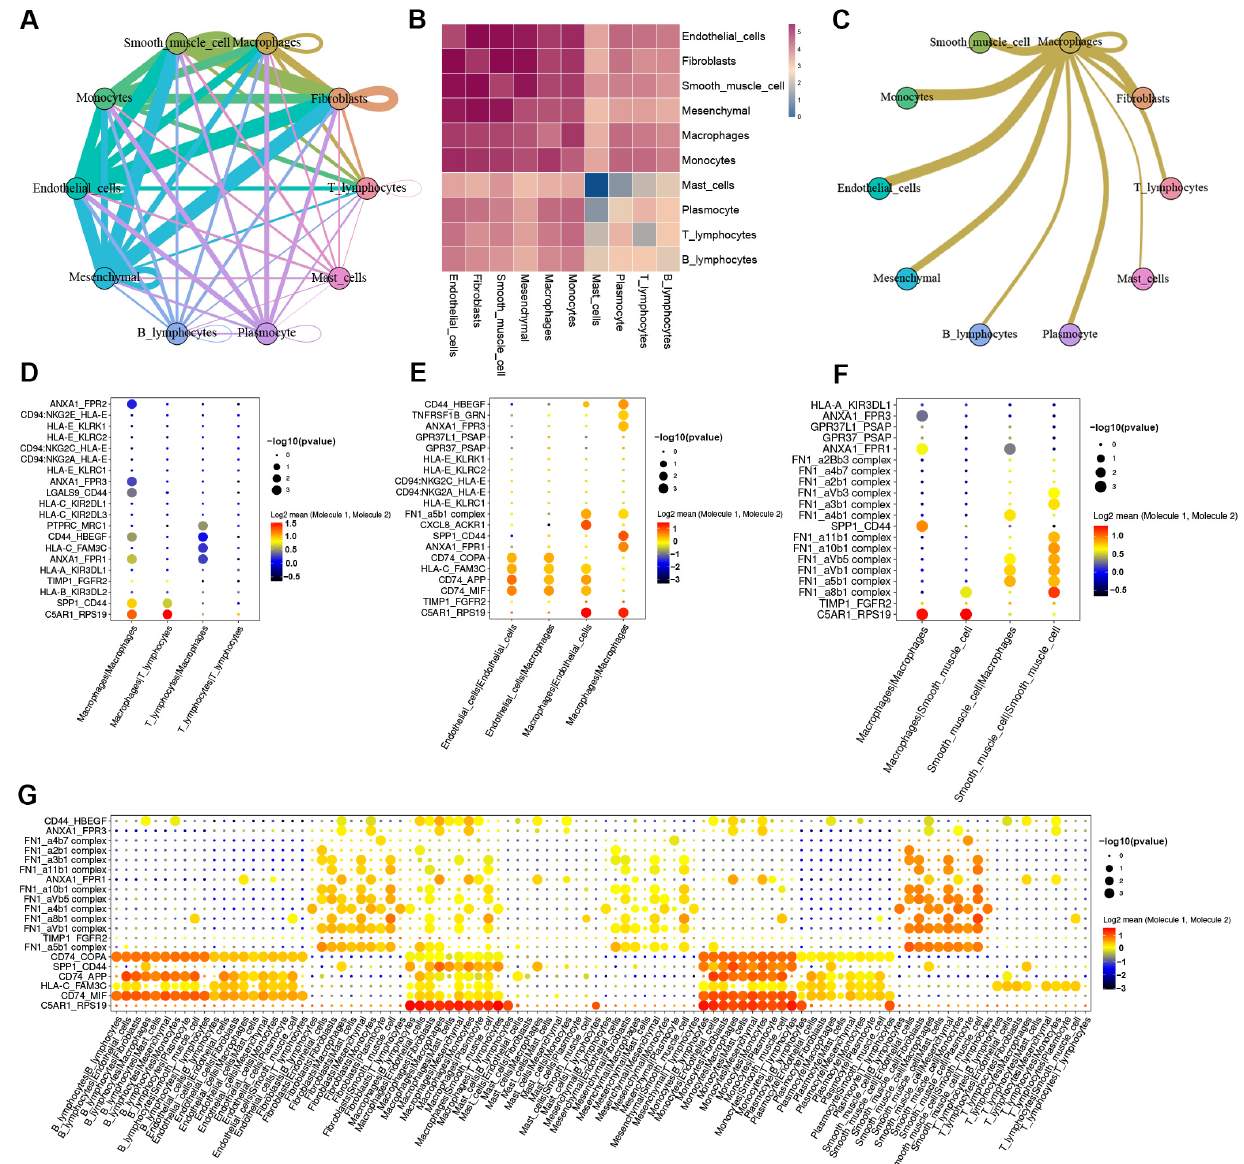
Figure 4. Cell–cell communication between macrophages and other cells in the AD group. ( A ) Network diagram of the weight and number of receptor–ligand interactions between the main cells. ( B ) Heatmap of the strength of communication between major cells. ( C ) Network diagram of communication between macrophages and other cells. ( D – F ) Bubble plot of receptor–ligand pairs for communication between macrophages and T cells and endothelial cells and smooth muscle cells, respectively. ( G ) Bubble plot of the receptor–ligand pairs for the 10 major cell types.